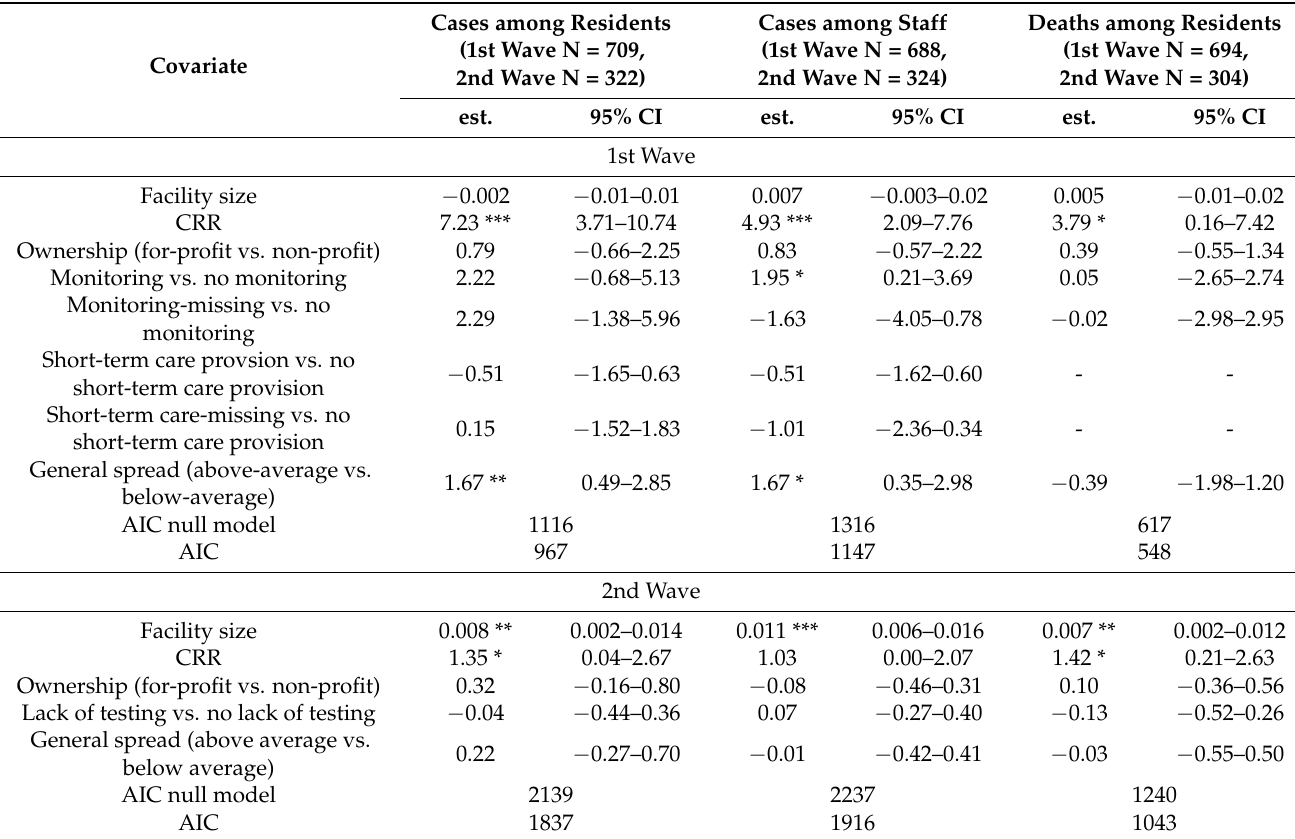
Table 4. Count models